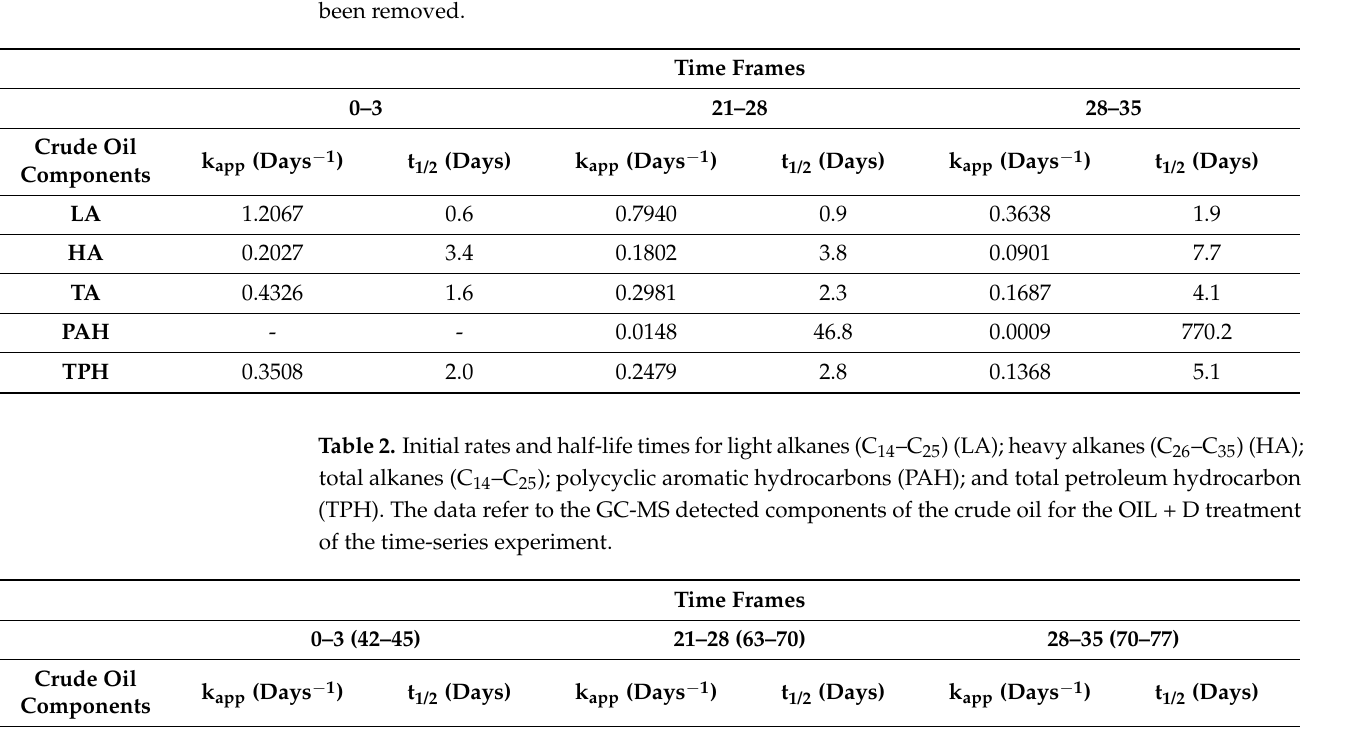
Table 1. Initial rates and half-life times for total alkanes (C 14 –C 35 ); light alkanes (C 14 –C 25 ) (LA); heavy alkanes (C 26 –C 35 ) (HA); polycyclic aromatic hydrocarbons (PAH); and total petroleum hydrocarbon (TPH). The data refer to the GC-MS detected components of the crude oil for the OIL treatment of the time-series experiment. Negative values due to detection errors from the GC-MS analysis have been removed.